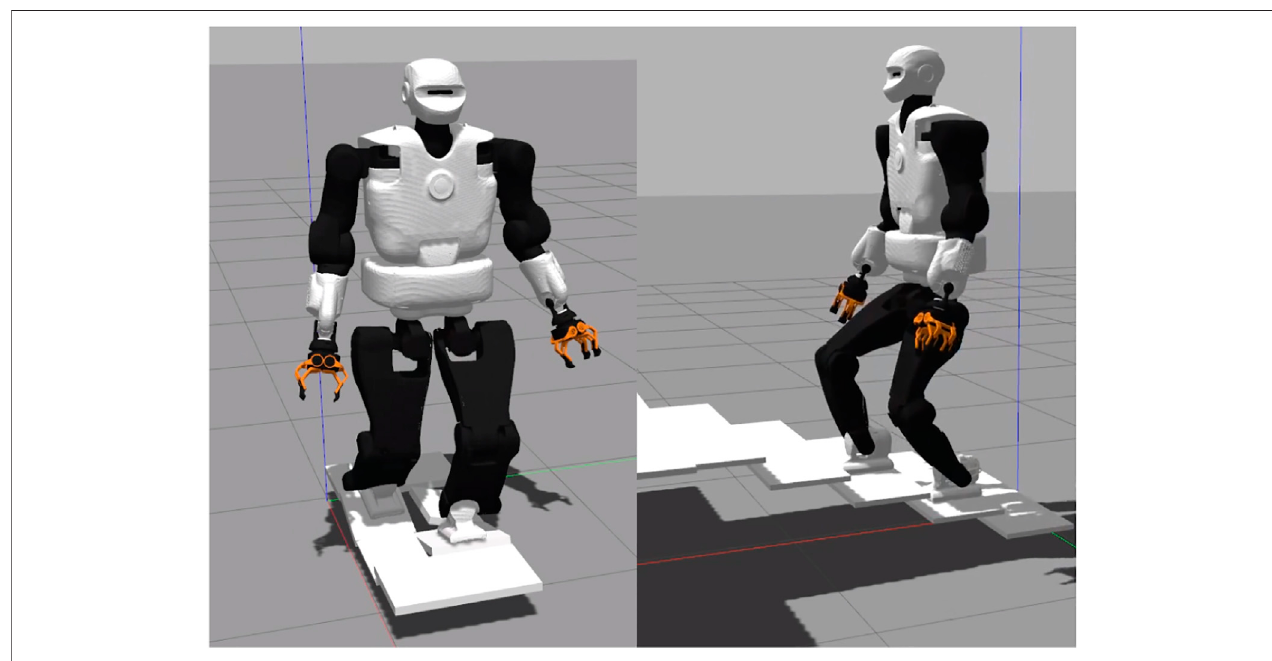
FIGURE 1 | Walking on tilted platforms and climbing